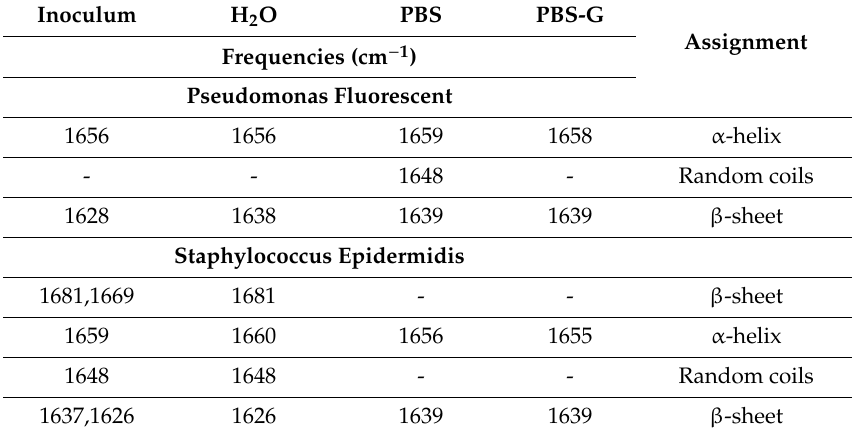
Table 2. P. fluorescens (PF) and SE Second derivative Amide I band frequencies and assignment to proteins secondary structure in Inoculum, H 2 0, PBS, and PBS-G media.